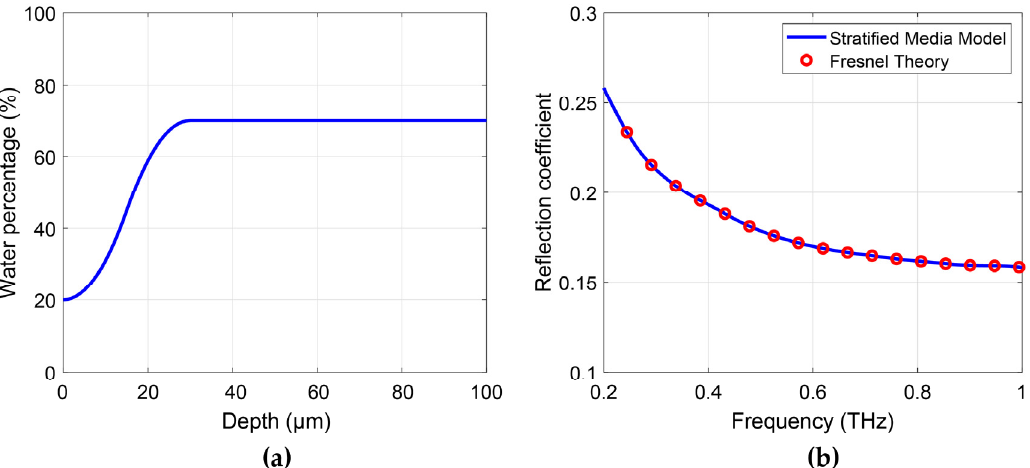
Figure 11. ( a ) Defined water concentration gradient; ( b ) Reflection coefficients calculated based on the stratified media model and Fresnel theory, respectively.